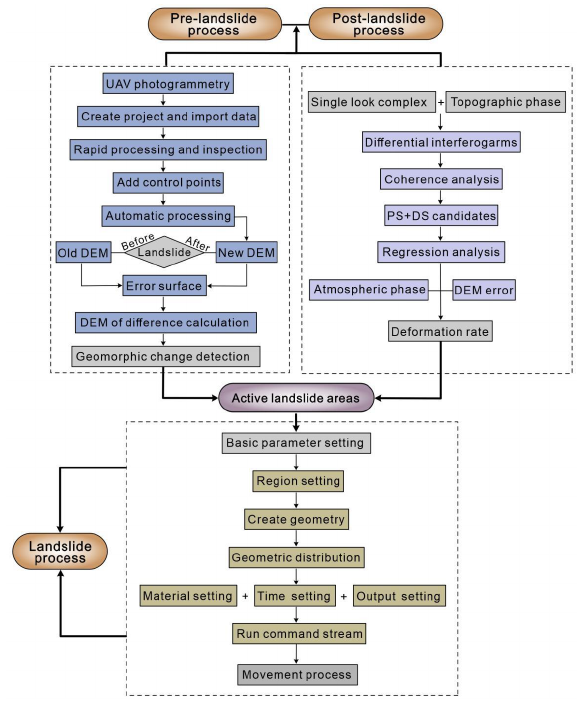
Figure 2. Workflow of research technical chain.